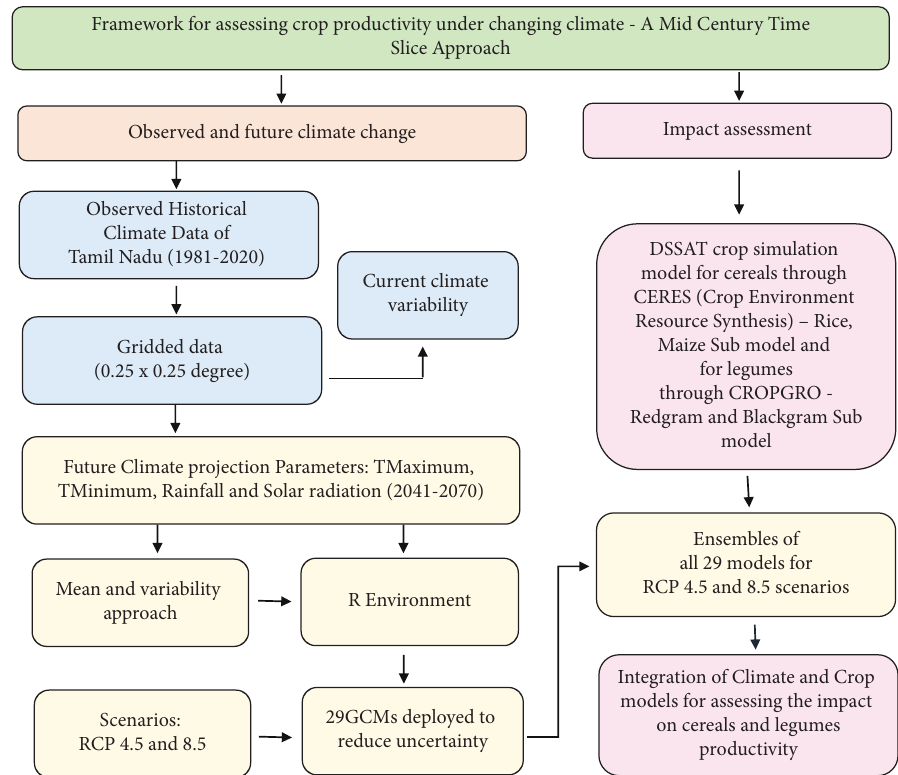
Figure 1: Framework for assessing the impact of climate change on productivity of cereals and